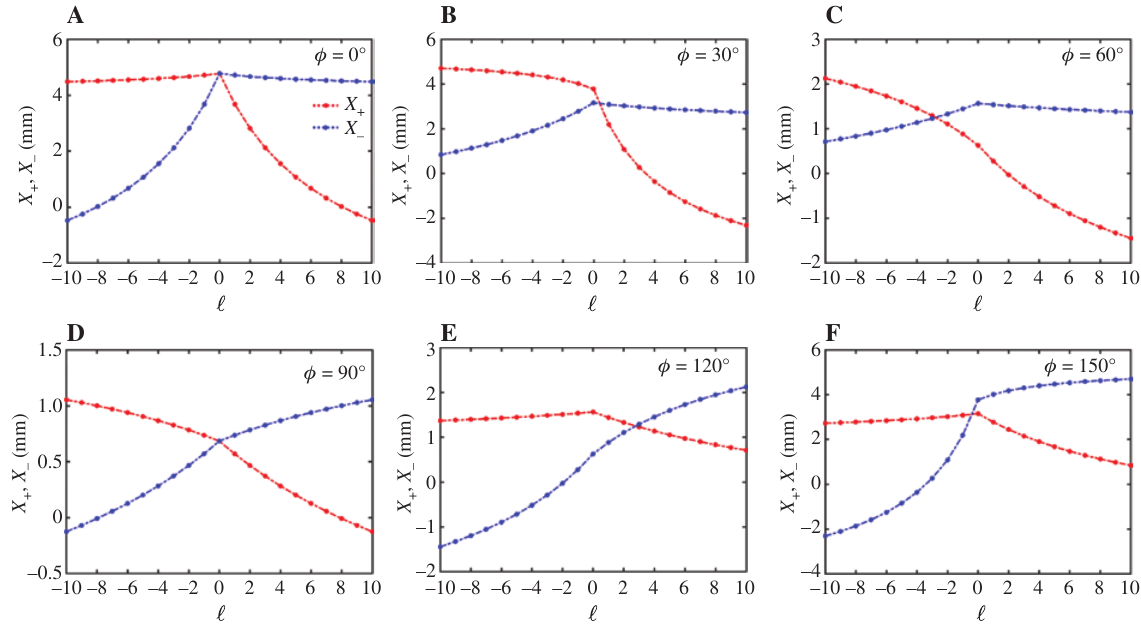
on the incident OAM ℓ for φ = 0 ° , 30 ° , 60 ° , 90 ° , 120 ° , 150 ° , respectively. ±